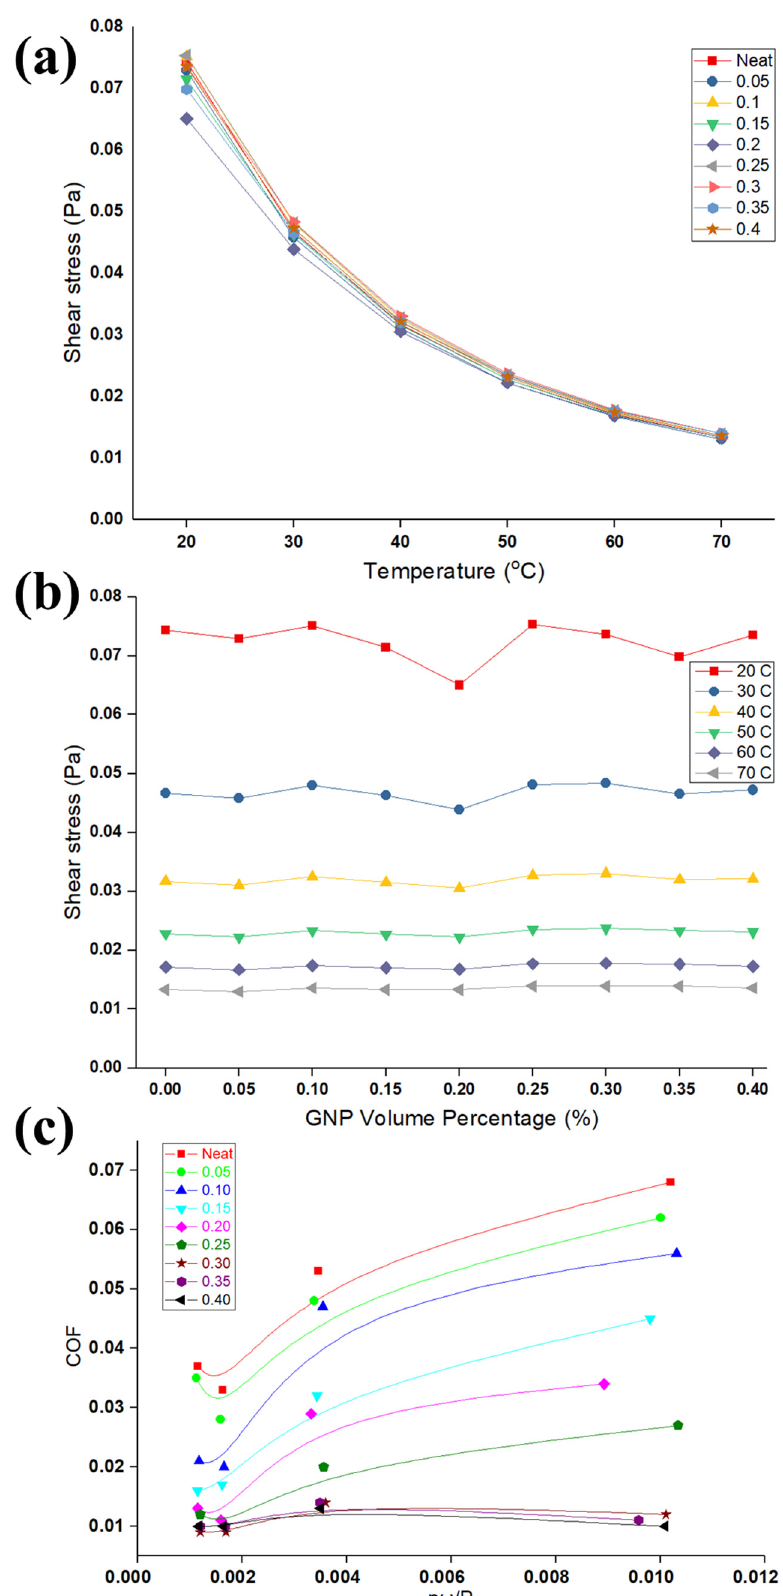
Figure 4. ( a ) Viscosity versus temperature for different concentrations of nanolubricants. ( b ) Viscosity versus volume percentage of GNPs for different loads. ( c ) Stribeck curve for different volume percentage of GNPs.